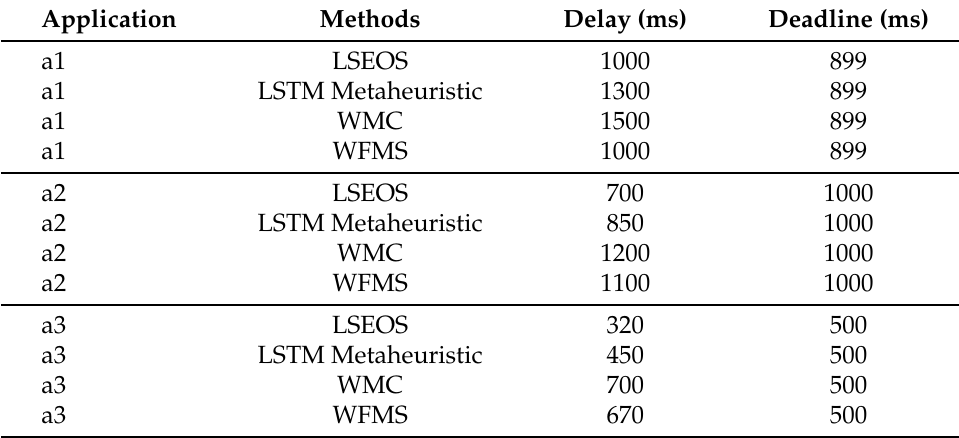
Table 5. Delay optimal workload assignment.